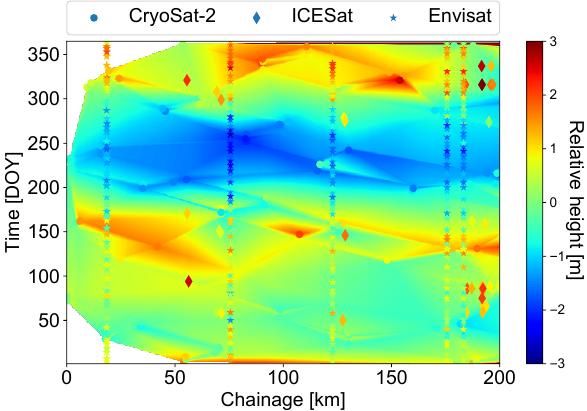
Figure 4. Spatiotemporal characterization of the annual water ele- vation changes of the lower Ogooué.